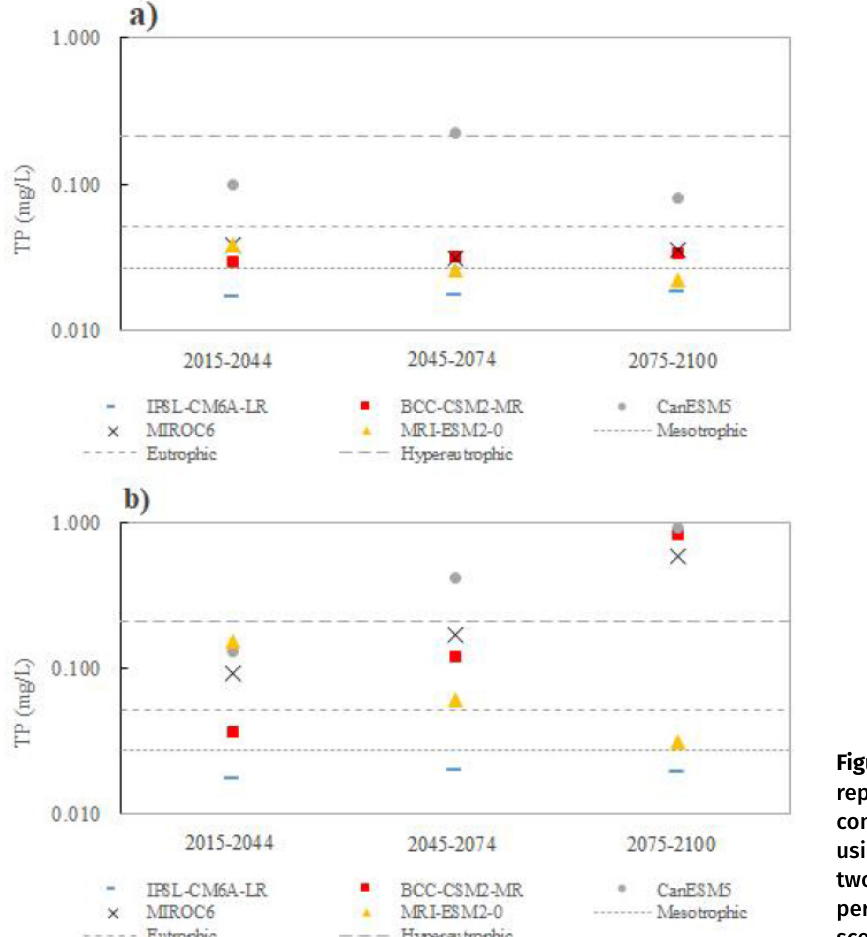
Figure 3. Projections of the representative values of TP concentration in Orós reservoir using five different GCMs with two SSPs-RCPs and three future periods. a) scenario SSP2-4.5; b) scenario